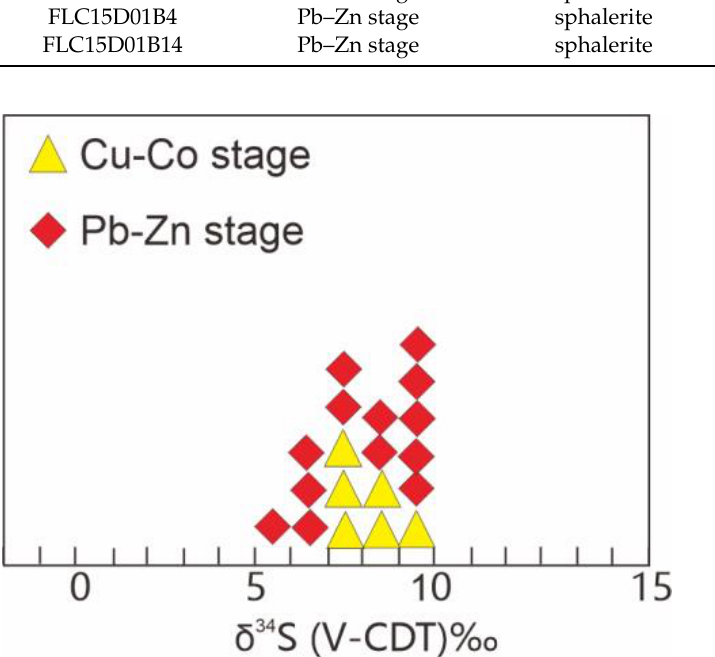
Figure 6. Histogram of the sulfur isotope composition of each stage from the Baiyangping Cu – Co – Pb – Zn deposit.